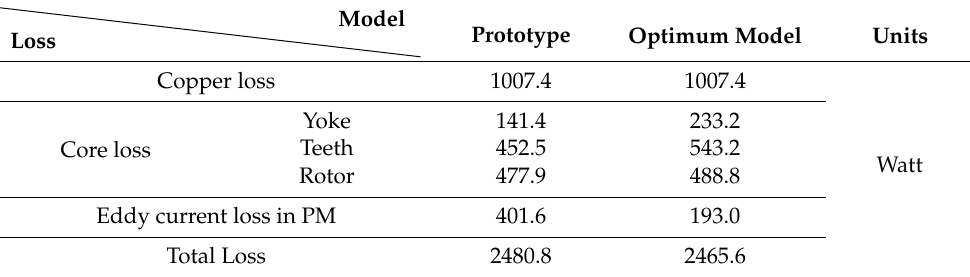
Table 7. Loss of each part.